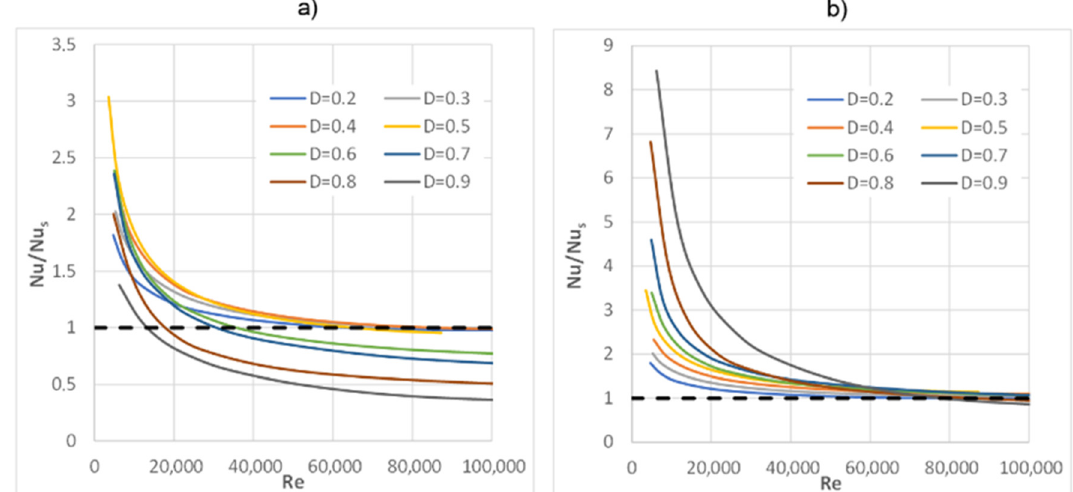
Figure 12. The ratio of the Nu number obtained from simulation to the Nu number for a smooth pipe Nu/Nu s ( Re ) as a function of the Re number, calculated on the basis of the average temperature: ( a ) from the entire pipe; ( b ) from the annular cross-section.